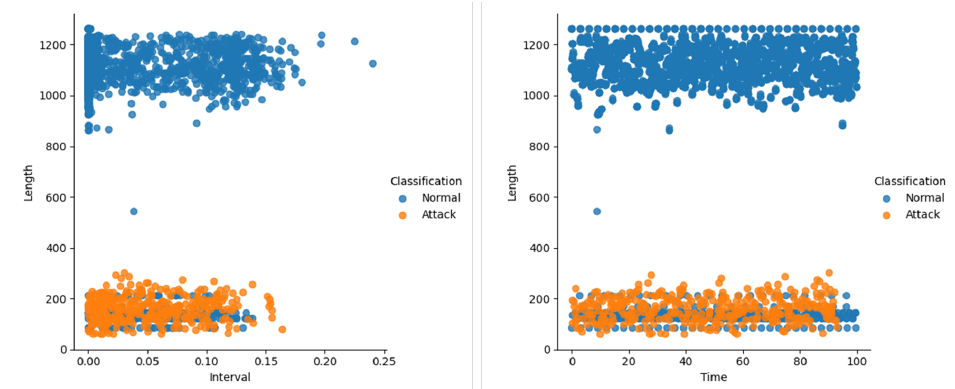
Figure 2. 2D scatter of a Gaussian Spreading based